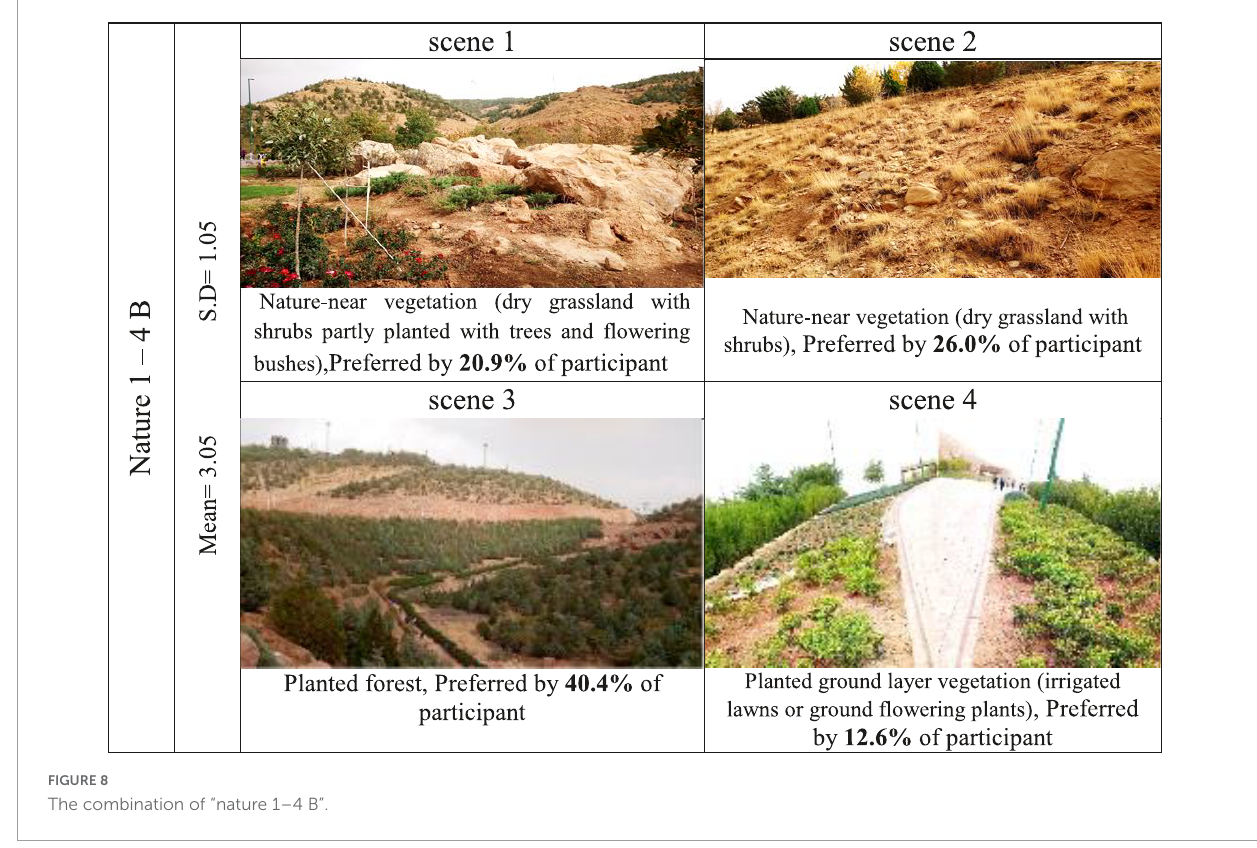
FIGURE8 The combination of “nature 1–4 B”.